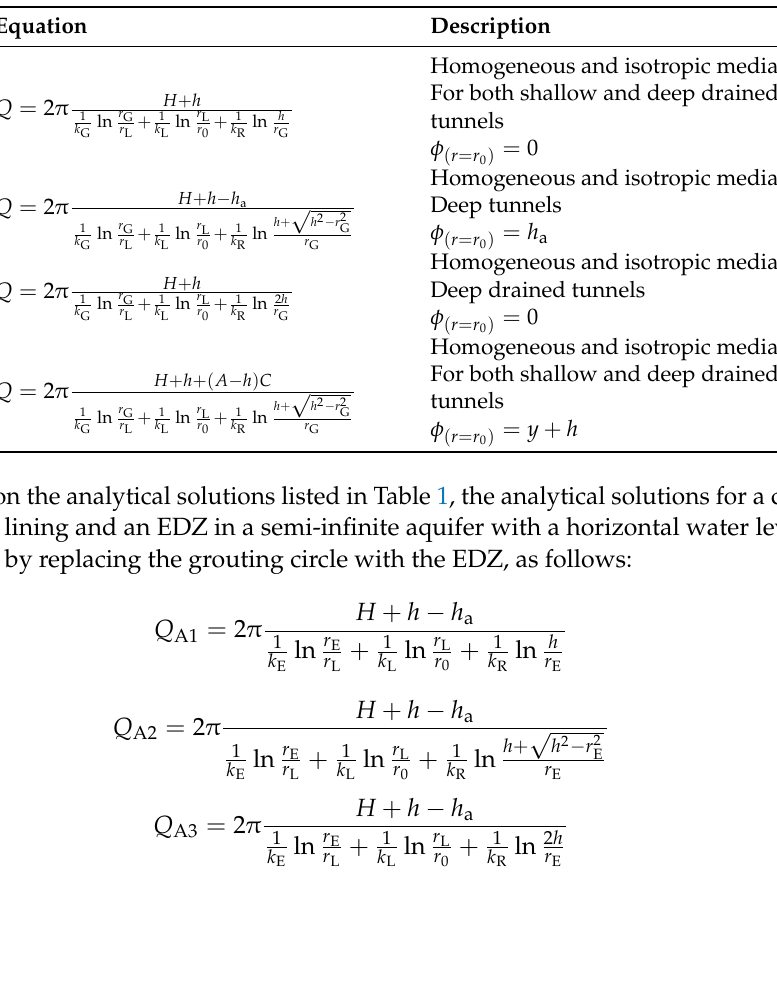
Table 1. Analytical solutions for a circular tunnel with lining and grouting circle in a semi-infinite aquifer with a horizontal water